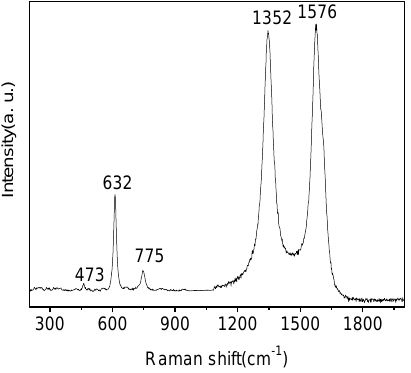
Figure 2. Raman spectrum of SnO 2 –CNTs nanocomposites.